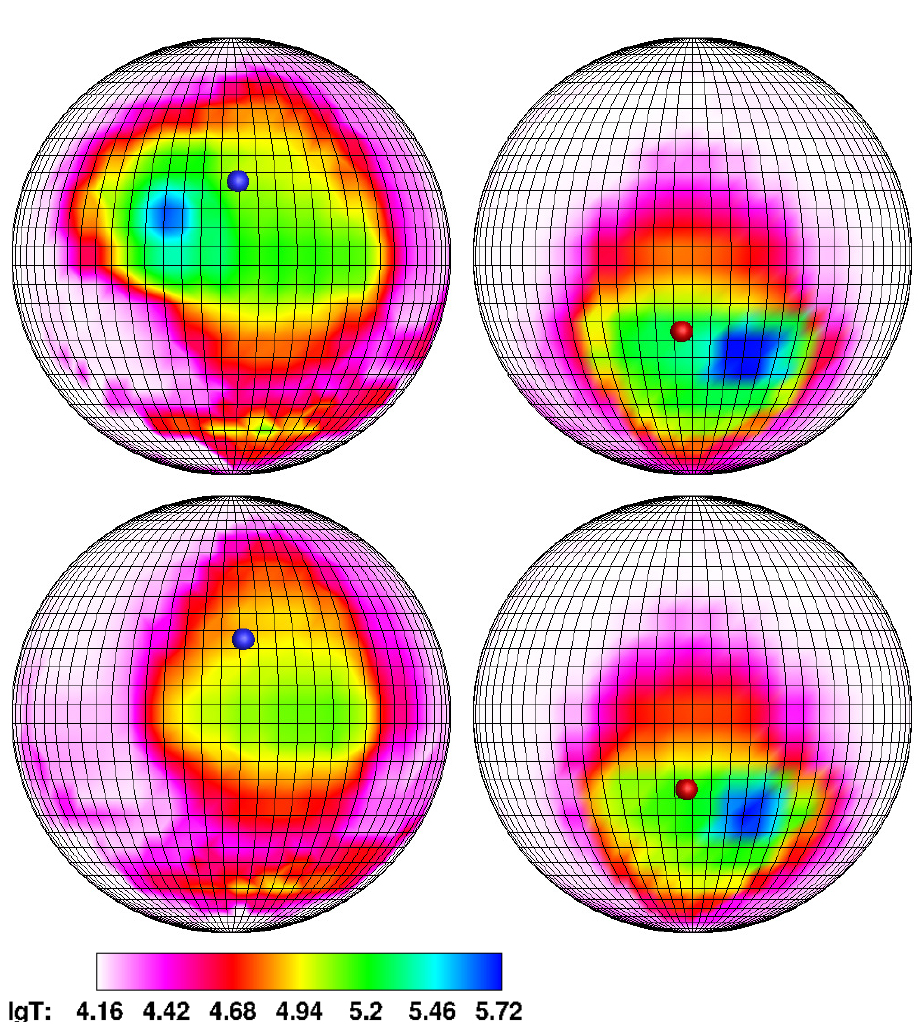
Figure 21. The same as in Figure 20, but for Phase 3 ( upper panel) and Phase 4 ( lower